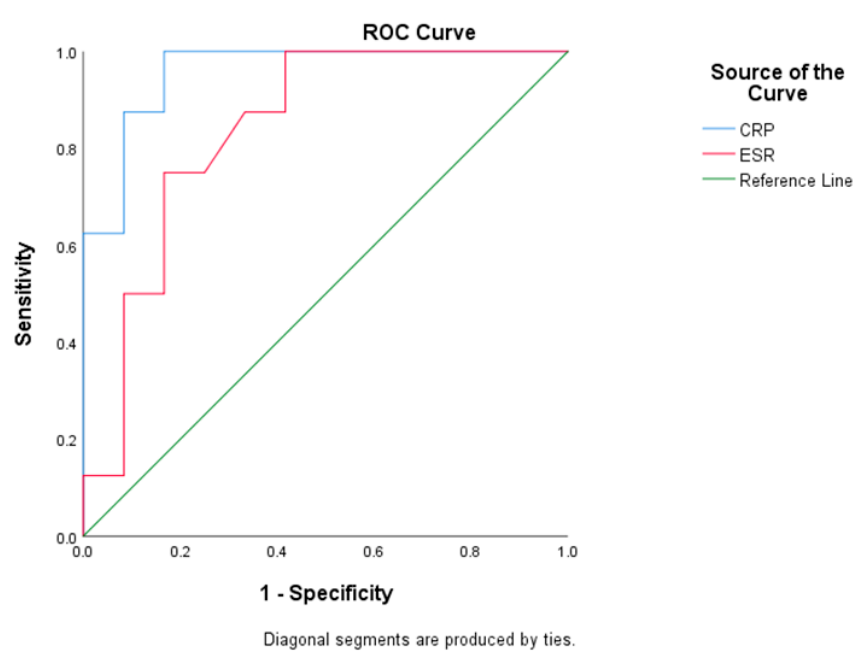
Figure 3. ROC graph for CRP and ESR. ROC curve of CRP and ESR as a risk factor of developing orbital complications in patients with IFS. The cutoff value of CRP was 1.025 mg/dL with a sensitivity of 0.875, a specificity of 0.917, and AUC of 0.958 ( p = 0.001). The cutoff value of ESR was 46.5 mm/h with a sensitivity of 0.750, a specificity of 0.833, and AUC of 0.839 ( p = 0.012).